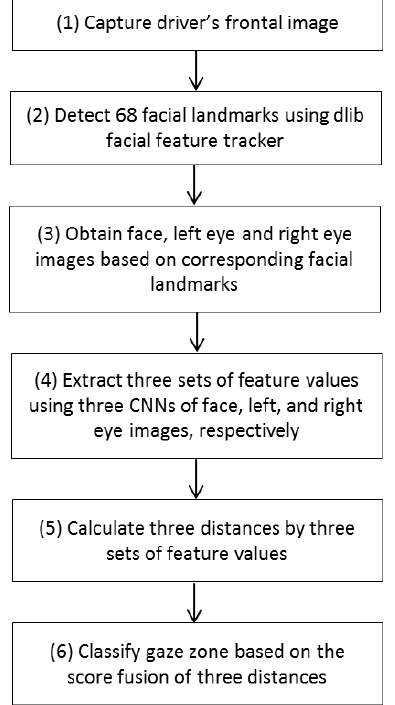
Figure 1. Flowchart of proposed system.